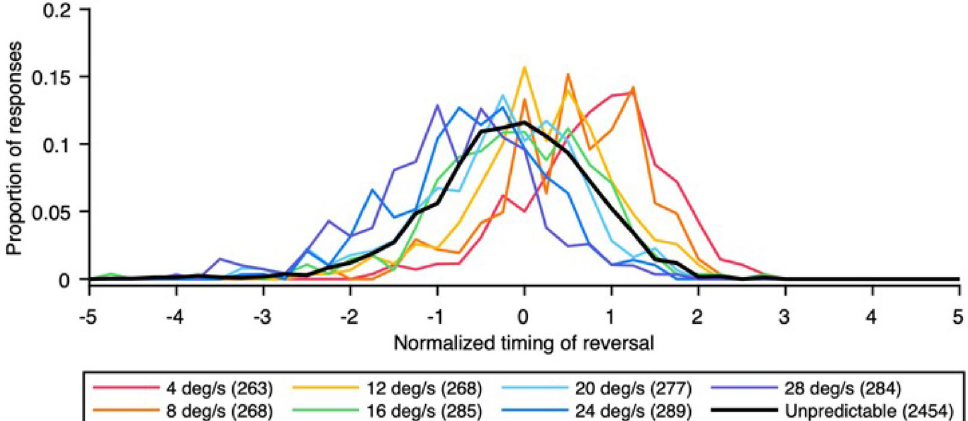
Figure 6. Pooled distribution of the normalized timing of eye reversal across all observers (bin size, 0.25). The values of median of each distribution are below; (4 deg/s: 1.00; 8 deg/s: 0.71; 12 deg/s: 0.39; 16 deg/s: 0.06; 20 deg/s: -0.08; 24 deg/s: − 0.44; 28 deg/s: − 0.68; unpredictable: 0.02). The colored and black lines indicate the predictable and unpredictable conditions, respectively. The values in parentheses in the legend represent the number of trials included in each